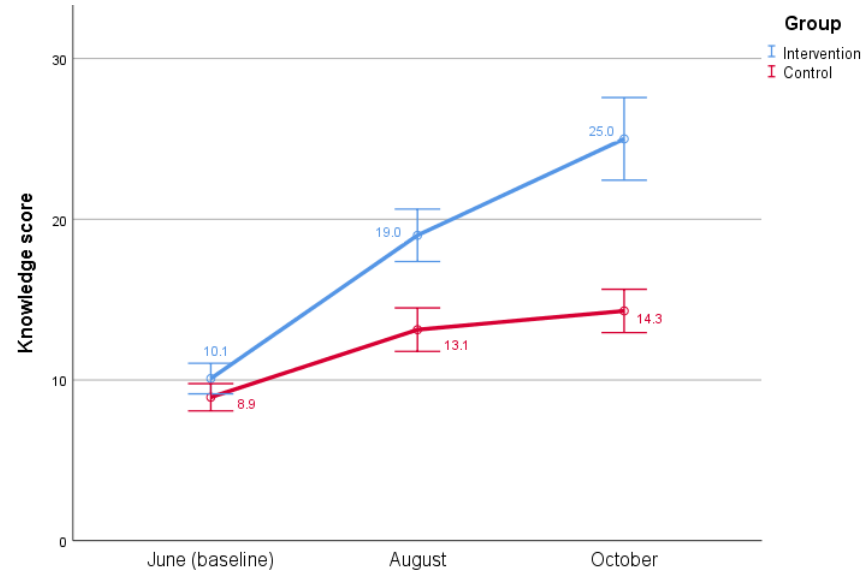
Figure 1. Change in mean dengue knowledge scores during three different times in 2020 in two low-income communities in Islamabad. Maximum knowledge score was 48.